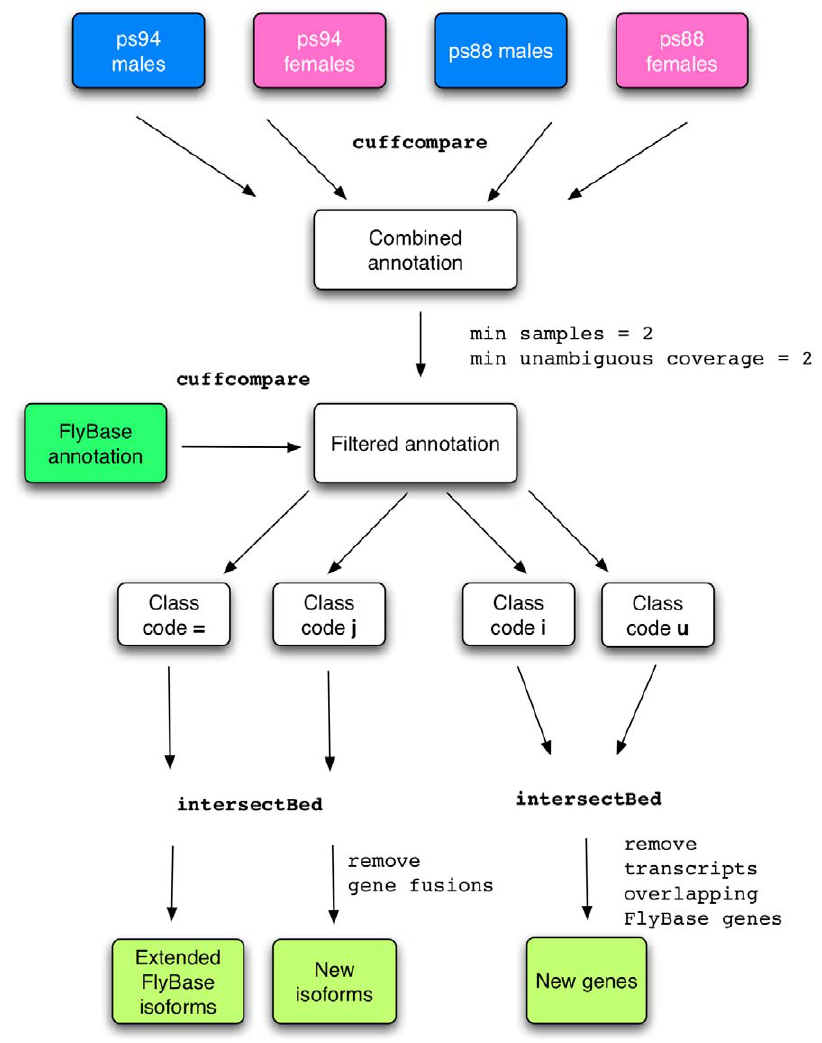
Figure 1. Annotation pipeline. Four samples of D. pseudoobscura are independently annotated with Cufflinks and then merged with cuffcompare. Isoforms confirmed in at least two samples and having at least 2-fold coverage by unambiguous reads are retained. The filtered annotation is compared against the FlyBase annotation using cuffcompare retaining extended FlyBase isoforms (=), new isoforms (j), new genes located in introns (i) or intergenic regions (u). Gene fusions are filtered out from the extended and new isoforms with intersectBed. New genes overlapping FlyBase genes directly or indirectly through transcripts detected in only one sample are removed using intersectBed.